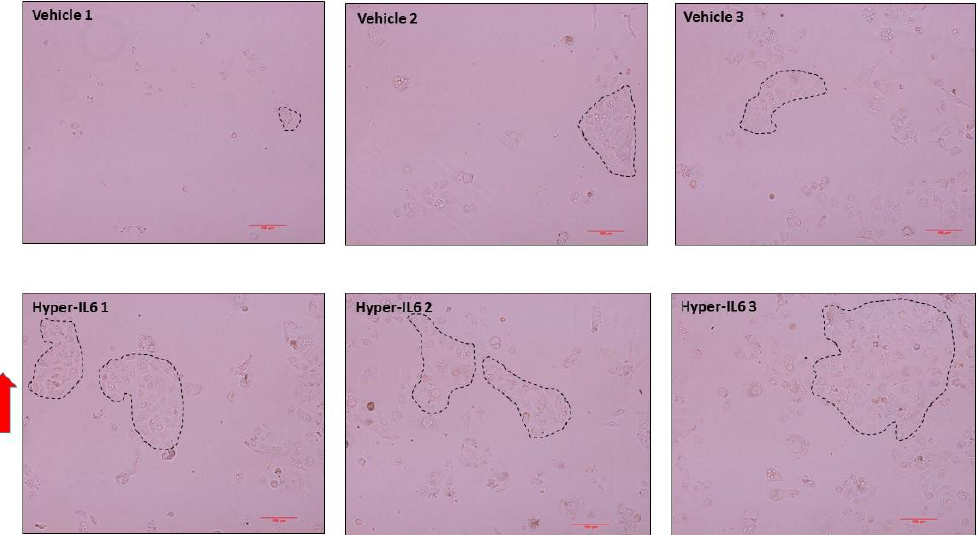
Figure 9. Hyper IL-6 promotes proliferation of HK2 cells after 24 h of treatment; Each image indicates a representation from an individual well. Dashed lines indicate areas of cellular foci; n = 3/group. Size bar = 100 µ m. Red arrow indicates increased proliferation in Hyper-IL6 treated cells.